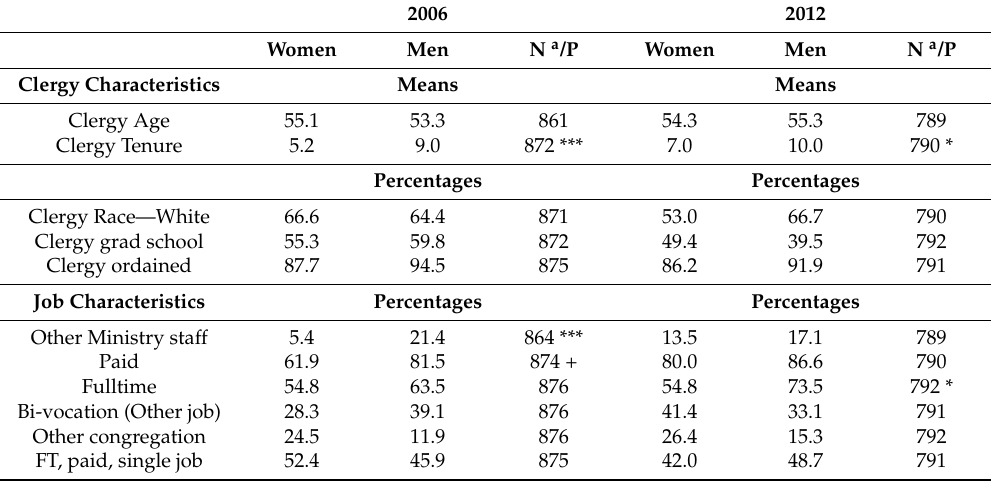
Table 5. Job and Clergy Characteristics—Descriptive Statistics and Bivariate